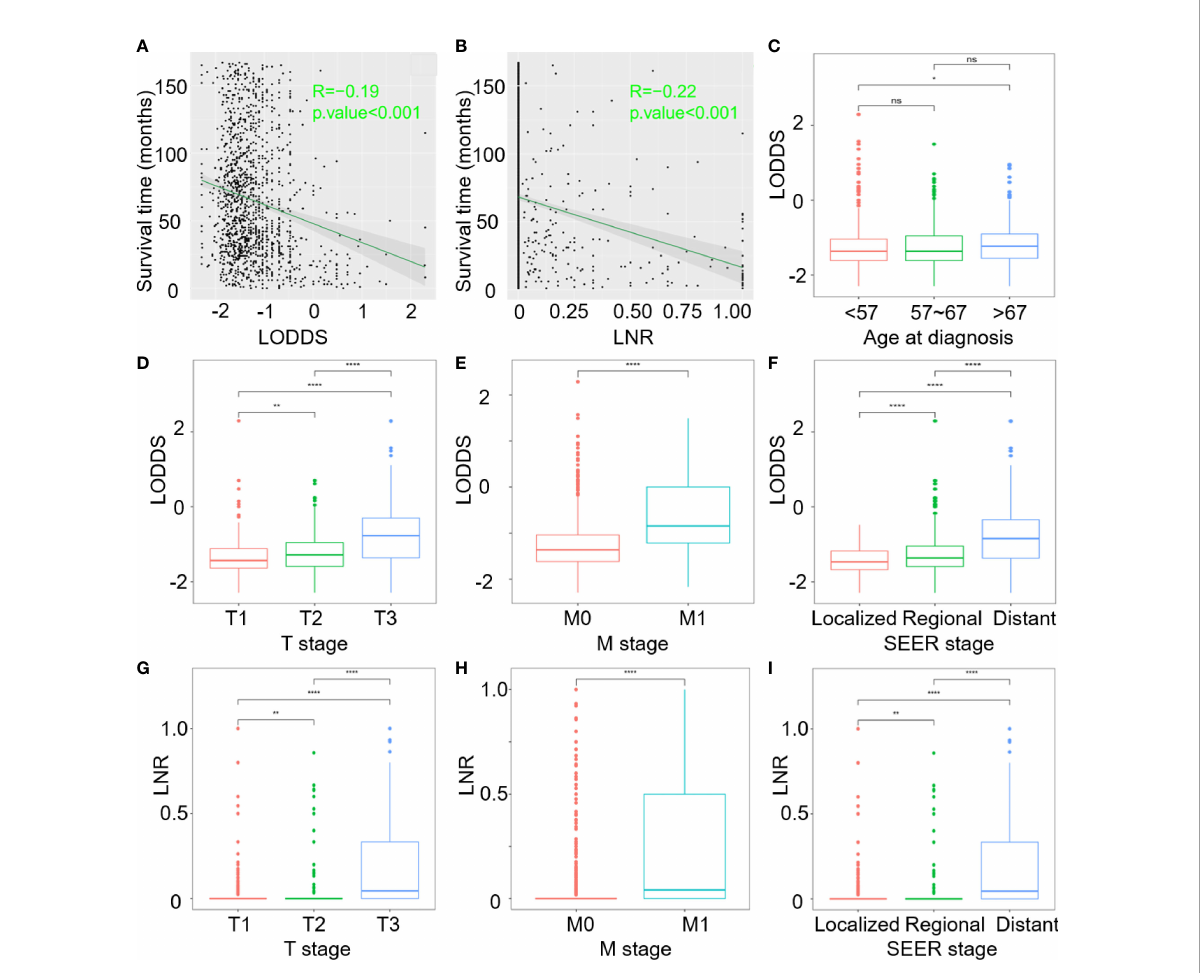
FIGURE 2 Correlation analysis of: (A) Survival time and continuous LODDS; (B) Survival time and continuous LNR; (C – F) LODDS with age at diagnosis, T stage, M stage, and SEER stage; (G – I) LNR with T stage, M stage and SEER stage. (ns, P>0.05; *P < 0.05; **P < 0.01; and ****P <